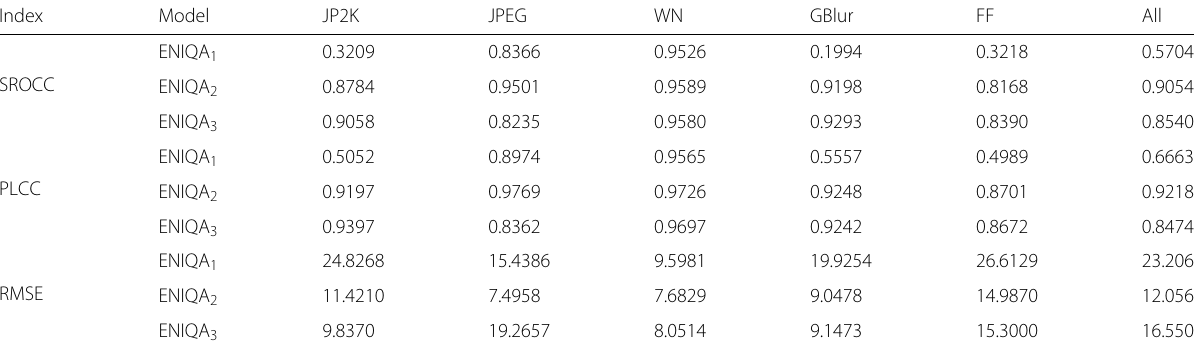
Table 2 Median SROCC/PLCC/RMSE values across 1000 train-test trials on the LIVE database